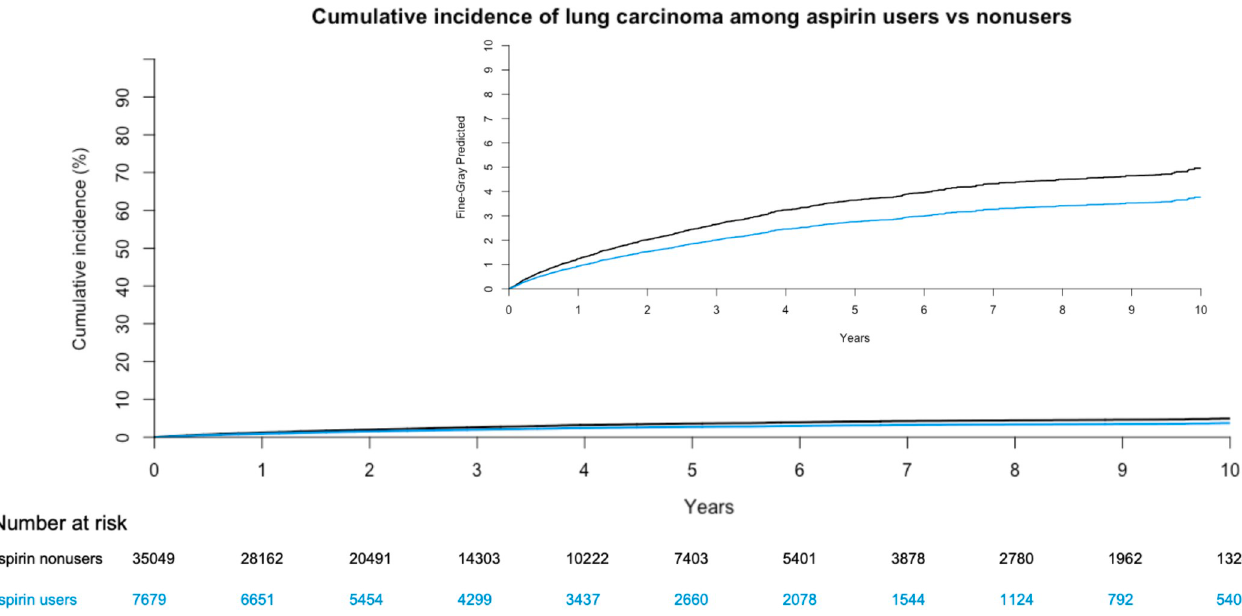
Fig 2. Cumulative incidence of lung carcinoma in aspirin and nonusers. Results were weighted by inverse probability of treatment and multivariate adjusted for age at index date, sex, comorbidities (diabetes, obesity, hypertension, cerebrovascular diseases, peripheral vascular diseases, congestive heart failure, coronary heart disease, arrhythmias, gastrointestinal bleeding and nongastrointestinal bleeding, cirrhosis, and coagulation defects), and drug history (use of antihypertensives, insulin, antidiabetics, beta-blockers, bronchodilators, insulin, NSAIDs, lipid-regulating drugs, and inhaled steroids) as well as factors relating to their socioeconomic status (alcoholism, nonsmoking etiologies of COPD, intravenous drug use, and number of inpatient hospital visits in the year prior to index), accounting for competing risks. The inset shows the same diagram with an expanded y-axis. Day 0 on the x-axis represents 90 days after index date. COPD, chronic obstructive pulmonary disease; NSAID, nonsteroidal anti-inflammatory